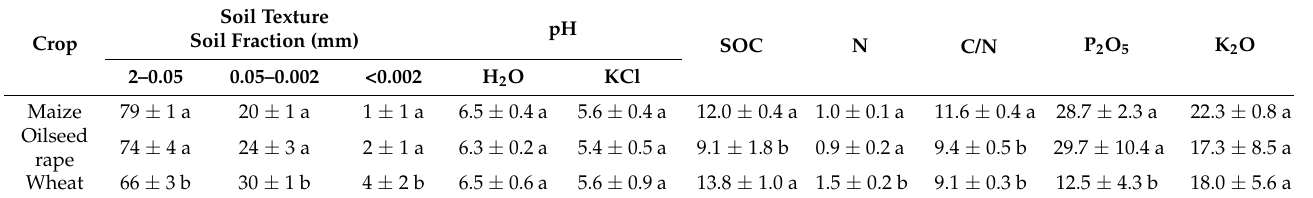
Table 1. Soil properties (means ± standard deviations) from wheat, maize and oilseed rape